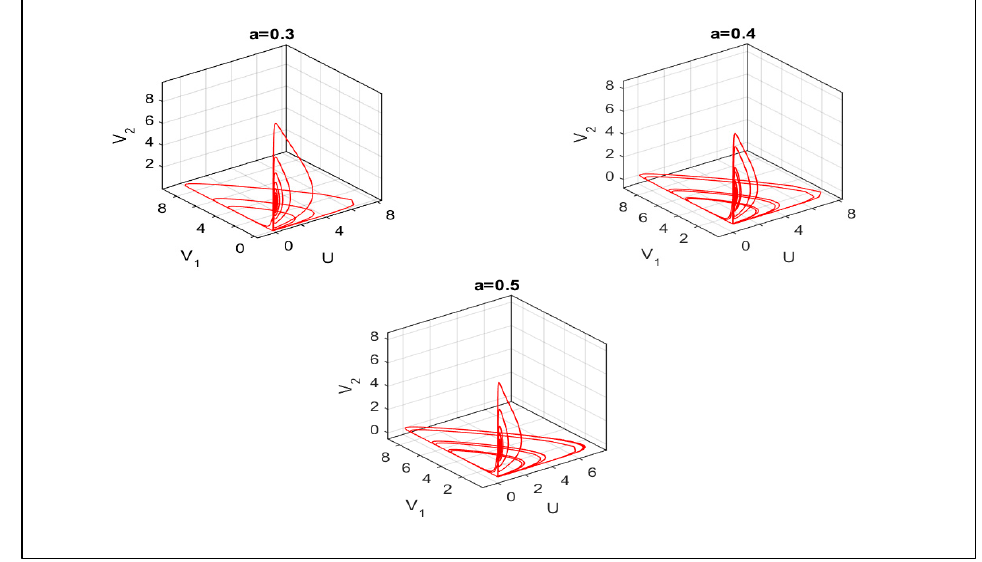
Figure 2. Phase portraits at different values of consumption rate of the common resource.